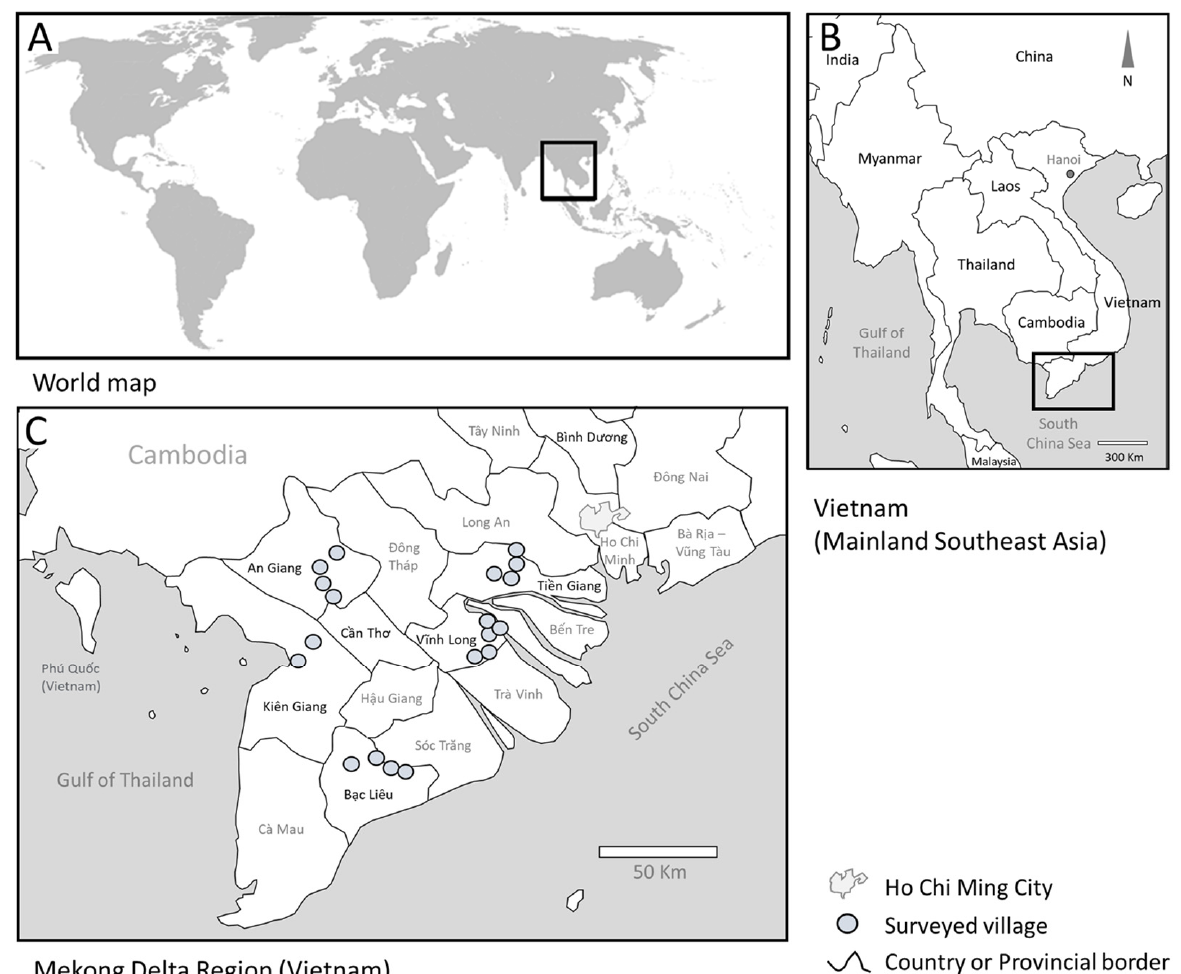
Figure 3. Map of study region. ( A ) indicates the location of mainland Southeast Asia, ( B ) indicates the location of the Mekong Delta Region (MDR) in Southeast Asia and ( C ) indicates 19 villages in rice-growing areas of the MDR that were surveyed in 2015.